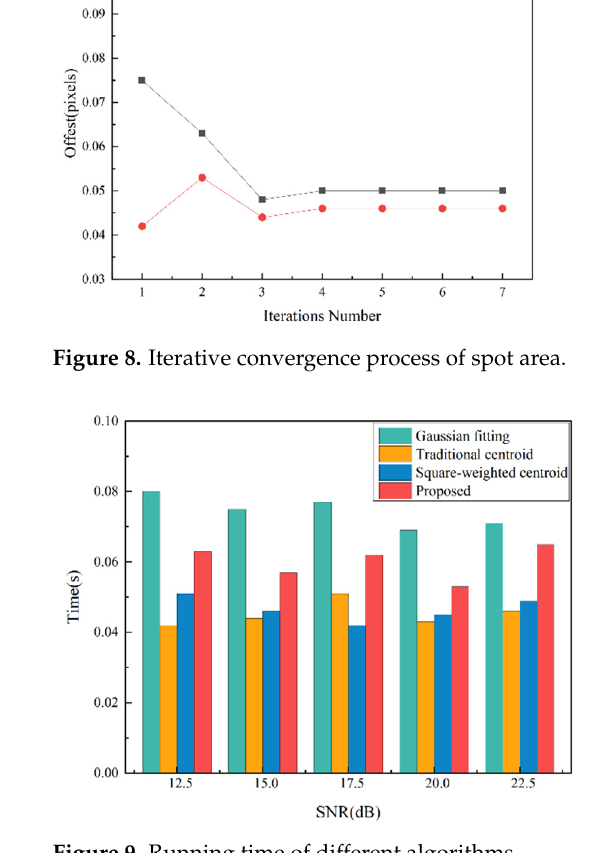
Figure 9. Running time of different algorithms.